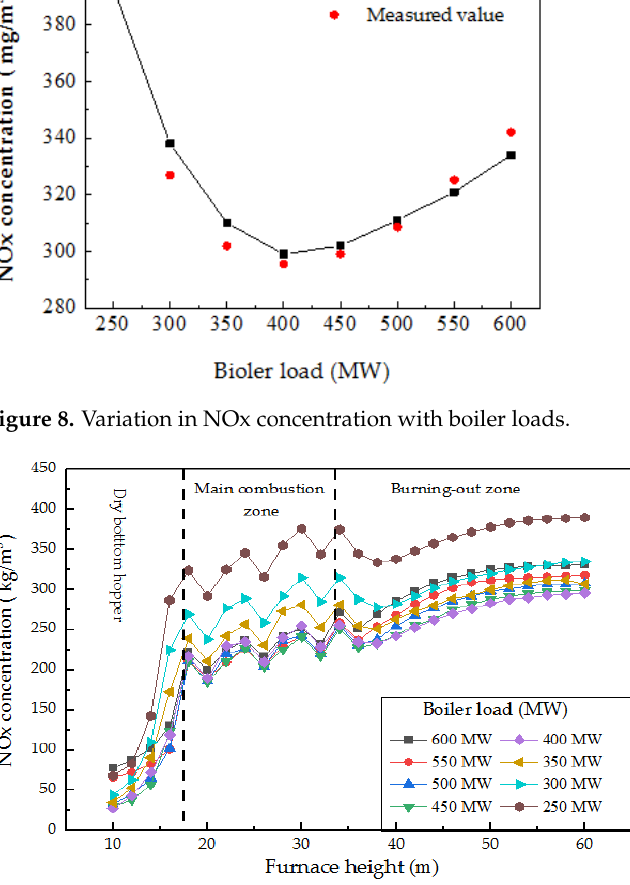
Figure 9. Variation in NOx concentration along the furnace height under different boiler